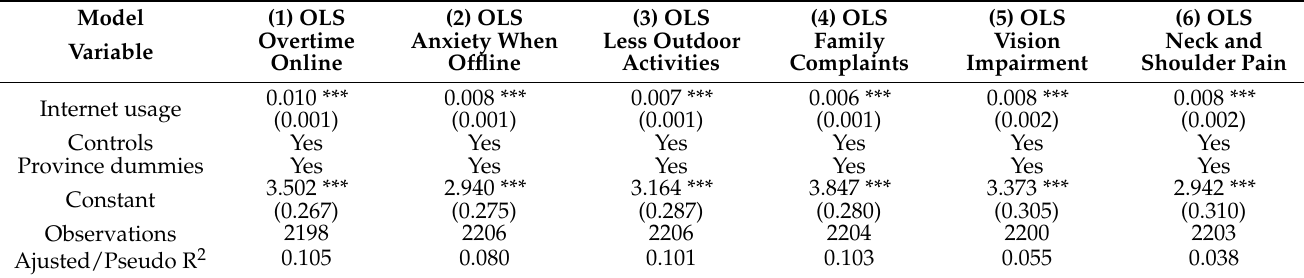
Table 8. Other effects of internet usage (overlong usage and